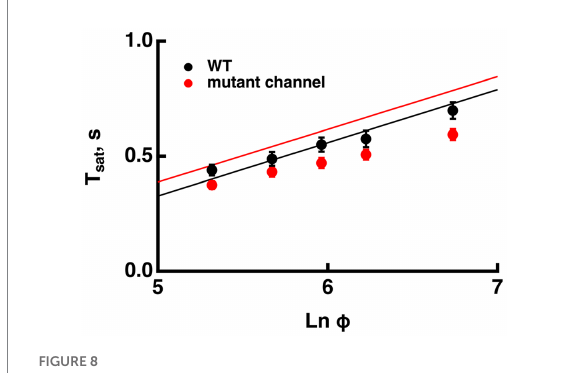
FIGURE 8 Increased CNG channel affinity for cGMP reduces saturation time with little change in Pepperberg slope in conflict with the model. T sat was measured from flash onset to 25% recovery. The mutant CNG channel lacked calmodulin binding so for modeling, the K cG was fixed at the minimum value at low Ca 2+ of 13 μ M. For the WT, the maximum value of 32 μ M was used for high Ca 2+ . The Pepperberg relation predicted by the model for rods expressing the mutant channel was shifted to longer saturation times, in comparison to that of wild type rods. Adapted from Chen et al.